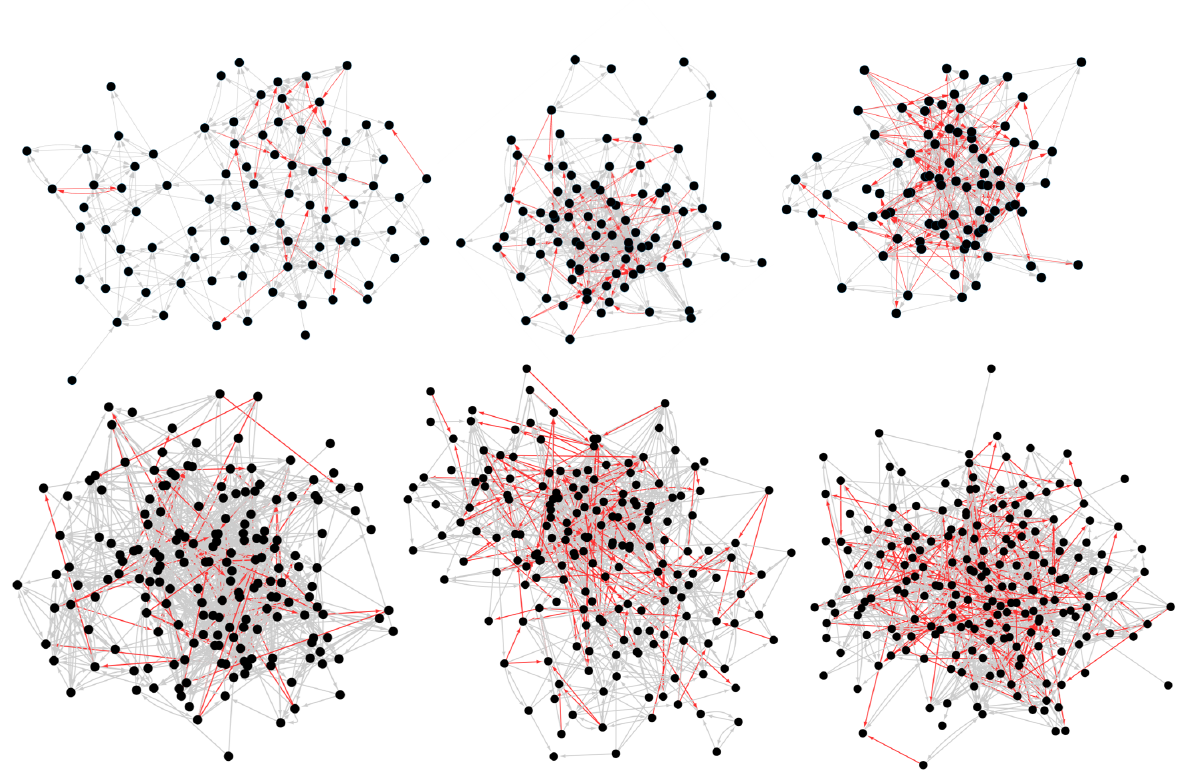
Figure 2: Six village networks of varying size and levels of antagonism. Friend ties are gray, and antagonistic ties are red. The top row represents three smaller villages (N = 86, 87, and 87 from left to right), and the bottom row represents three larger villages (N = 204, 188, and 184) chosen from the 176 villages. The left column shows villages with low animosity (8.5–9.6 percent), the middle column shows villages with medium animosity (17.2–21.6 percent), and the right column shows villages with high animosity (40.0–32.2 percent) as measured by the ratio of negative ties to positive ties in the